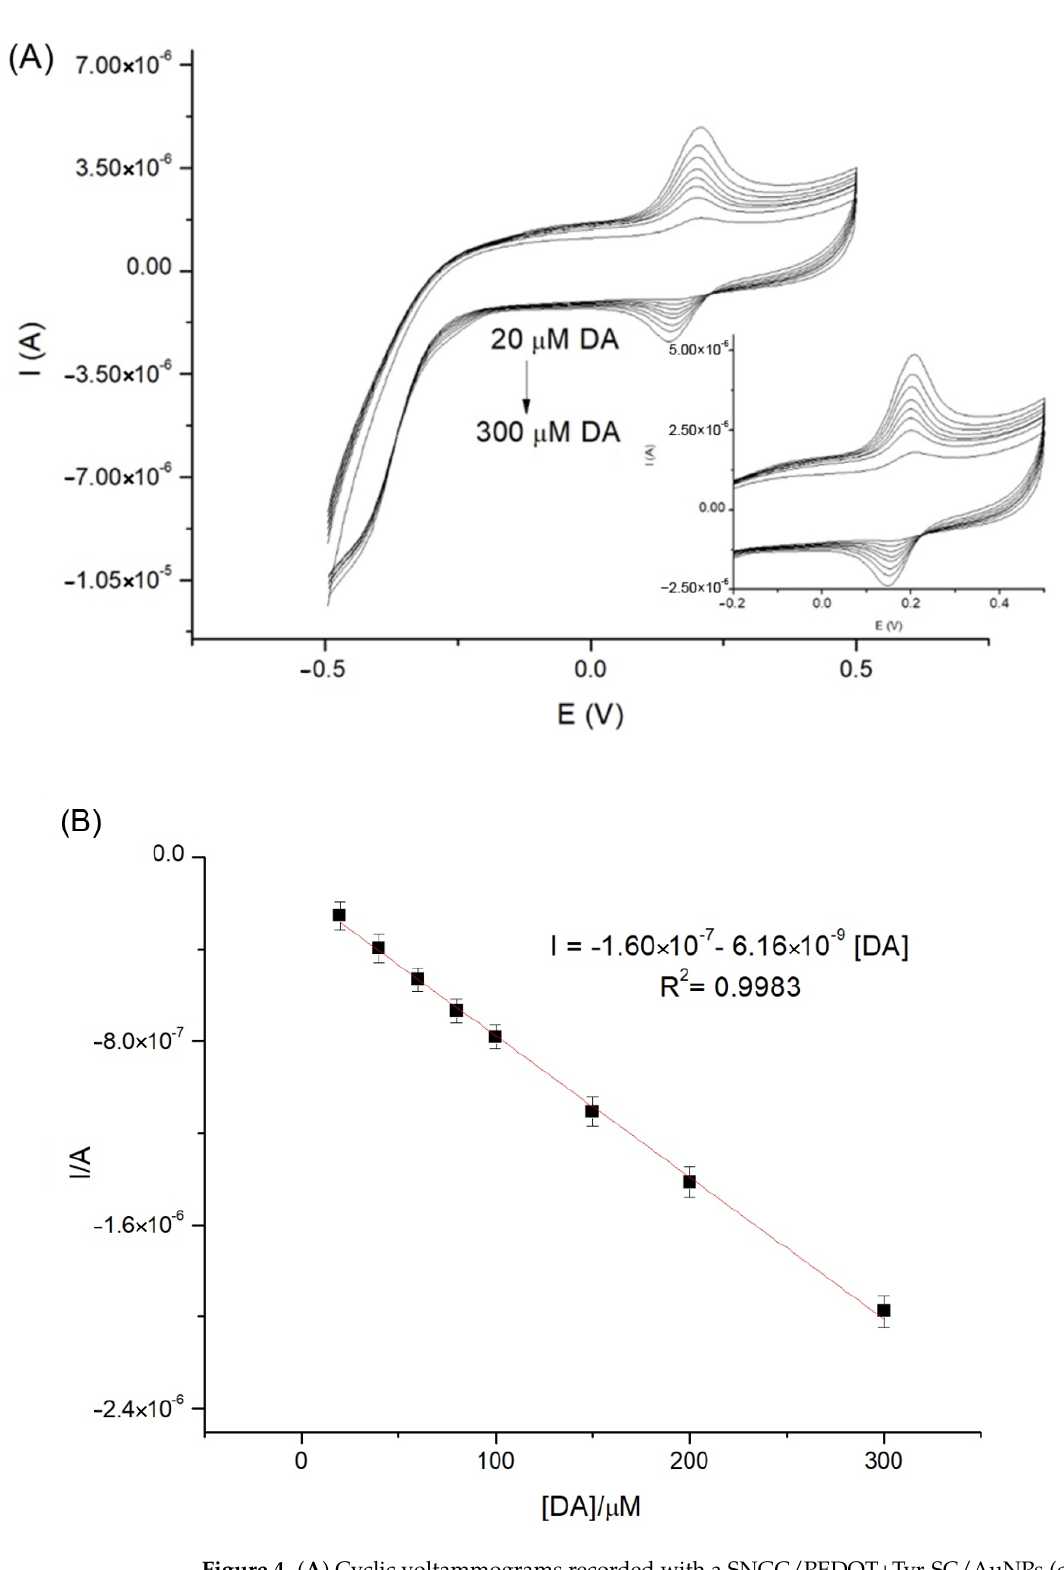
Figure 4. ( A ) Cyclic voltammograms recorded with a SNGC/PEDOT+Tyr-SC/AuNPs (drop) biosen- sor in 0.1 M PBS pH 7, with different dopamine concentrations ranging from 20 to 300 µM (20, 40, 60, 80, 100, 150, 200, 300), and ( B ) the corresponding calibration plot with the fitting equation and the determination coefficient (R 2 ). Error bars correspond to three replicates (n = 3).